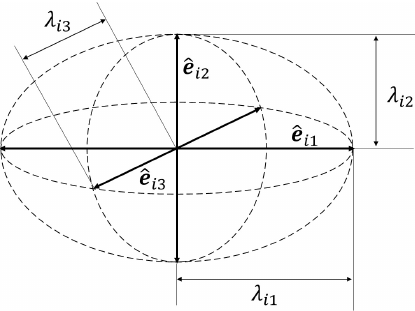
Figure 6. The eigenvectors and eigenvalues of the tensor matrix. The eigenvectors correspond to the principal directions of the ellipsoid/ellipse, and the eigenvalues encode the size and shape of the ellipsoid/ellipse.